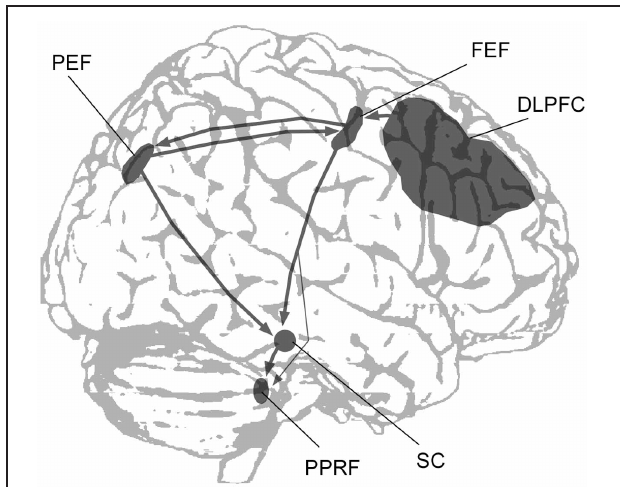
FIGURE 1 | A simplified scheme showing the main cortical regions and subcortical structures involved in the control of saccadic eye movements (DLPFC, dorsolateral prefrontal cortex; FEF, frontal eye field; PEF, parietal eye field; PPRF, paramedian pontine reticular formation; SC, superior